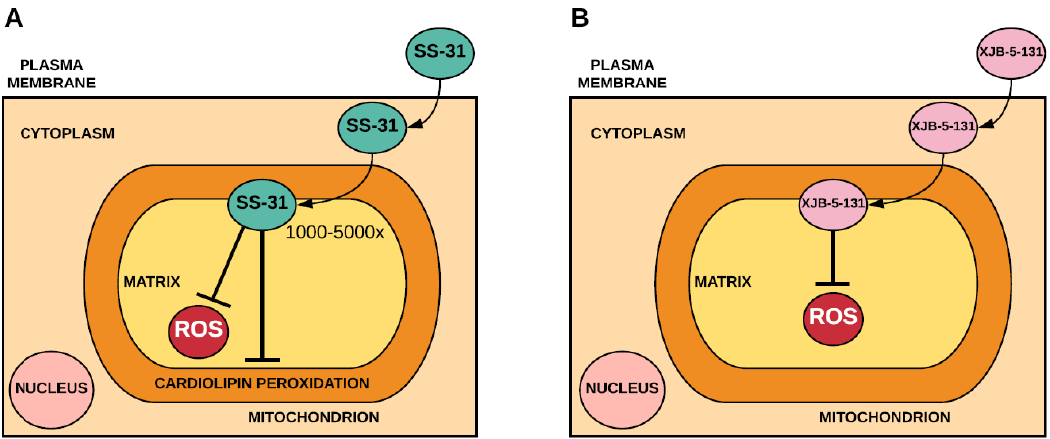
Figure 2. Accumulation and antioxidant mechanism of Szeto-Schiller-31 (SS-31) ( A ) and XJB-5-131 ( B ). SS-31 accumulates several-thousand fold within the mitochondria where it binds to cardiolipin. In acting as an antioxidant, it is likely that SS-31 prevents peroxidation of cardiolipin and decreases mitochondrial ROS production. XJB-5-131 accumulates within the mitochondria independent of the membrane potential, where it acts as an antioxidant by scavenging mitochondrial ROS.